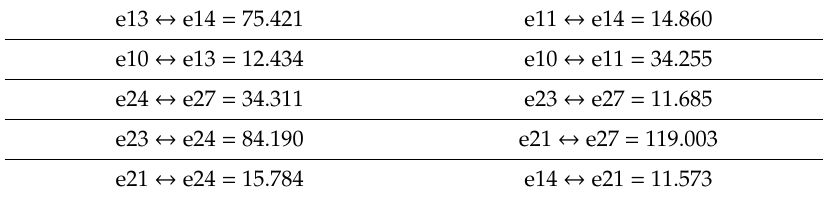
Table 3. Modification Indices ≥ 11 for Step 2 modifications of observed variables